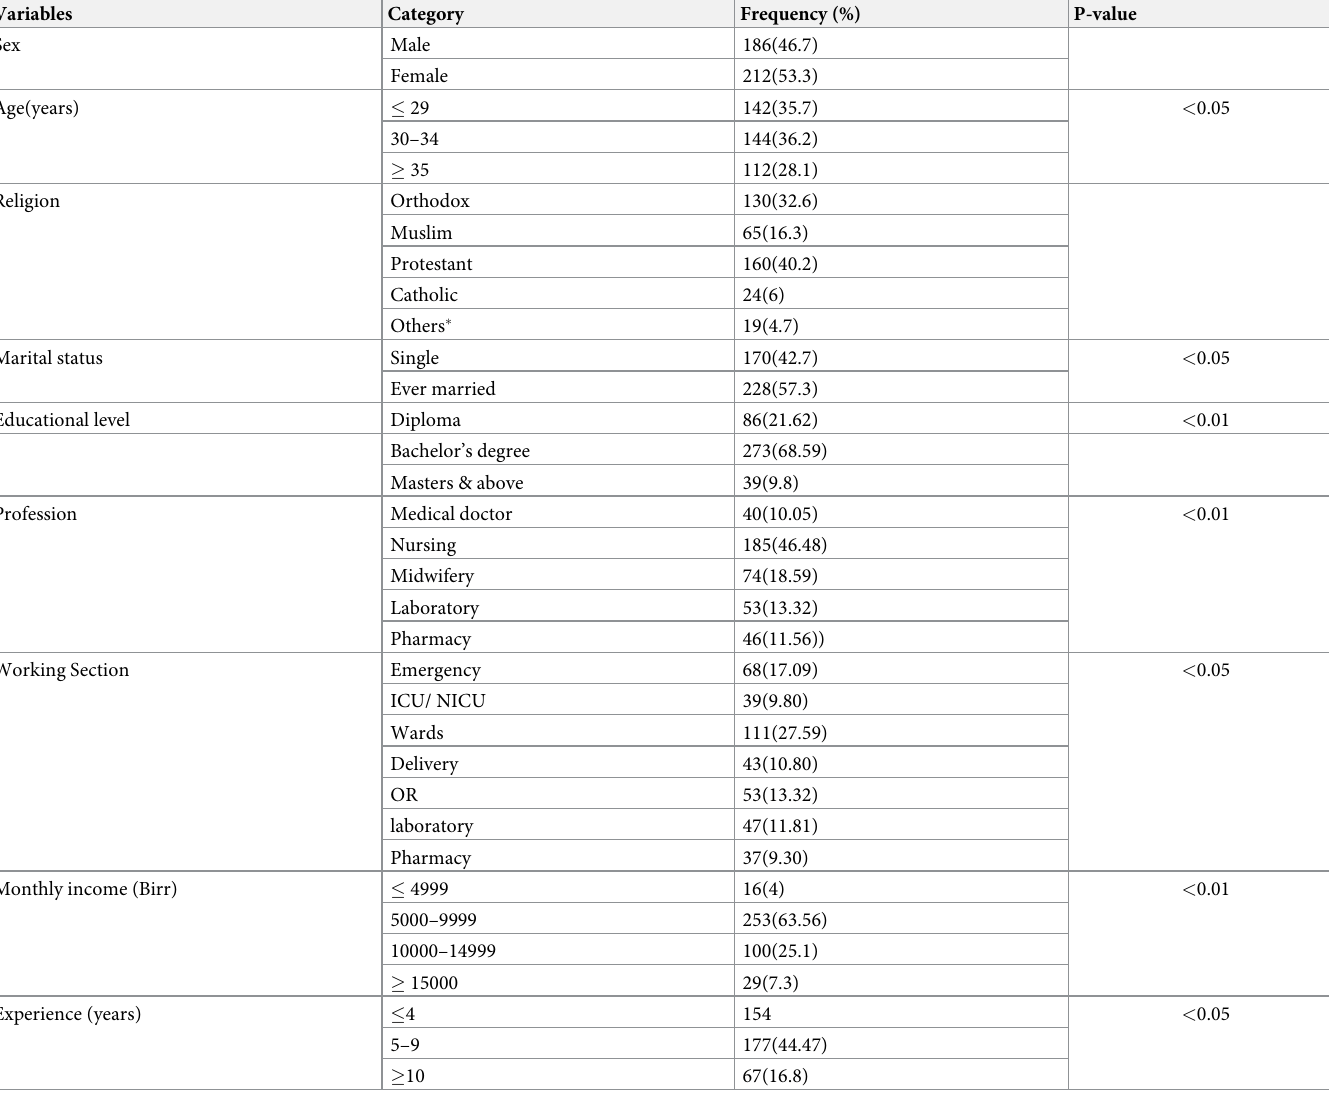
Table 1. Socio-demographic characteristics of health care workers working at public hospitals in Sidama national regional state, Southern Ethiopia, 2021 (N = 398).